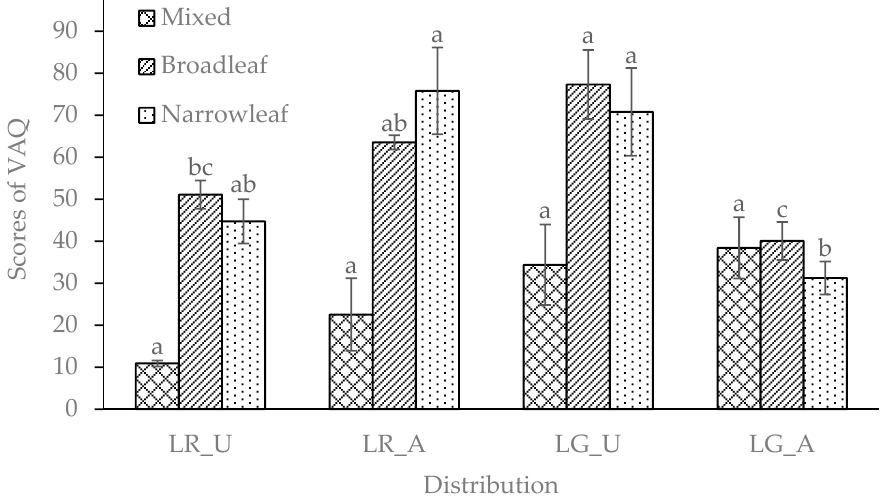
Figure 7. The mean value of different design distribution effect on visual aesthetic quality (VAQ) of three landscape background types (Mixed: Sophora japonica and Juniperus chinensis , Broadleaf: Sophora japonica , Narrowleaf: Juniperus chinensis ). L R_U , Red-Single of Location; L R_A , Red-Group of Location; L G_U , Green-Single of Location; L G_A , Green- Group of Location. Lower case letters were used to compare the difference among L R_U , L R_A , L G_U , and L G_A .